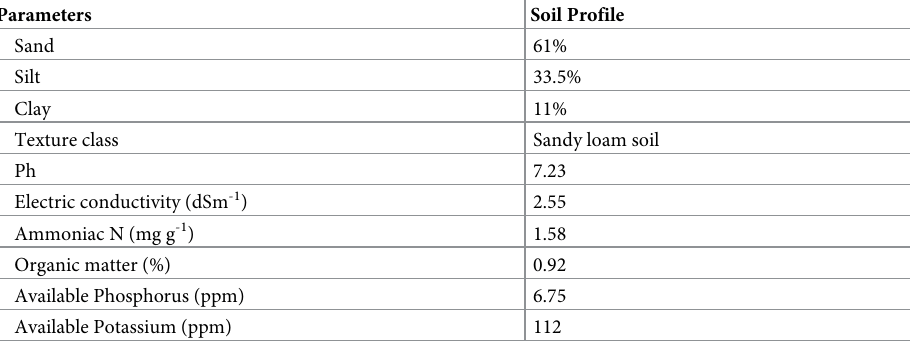
Table 1. Physical and chemical properties of the experimental soil.